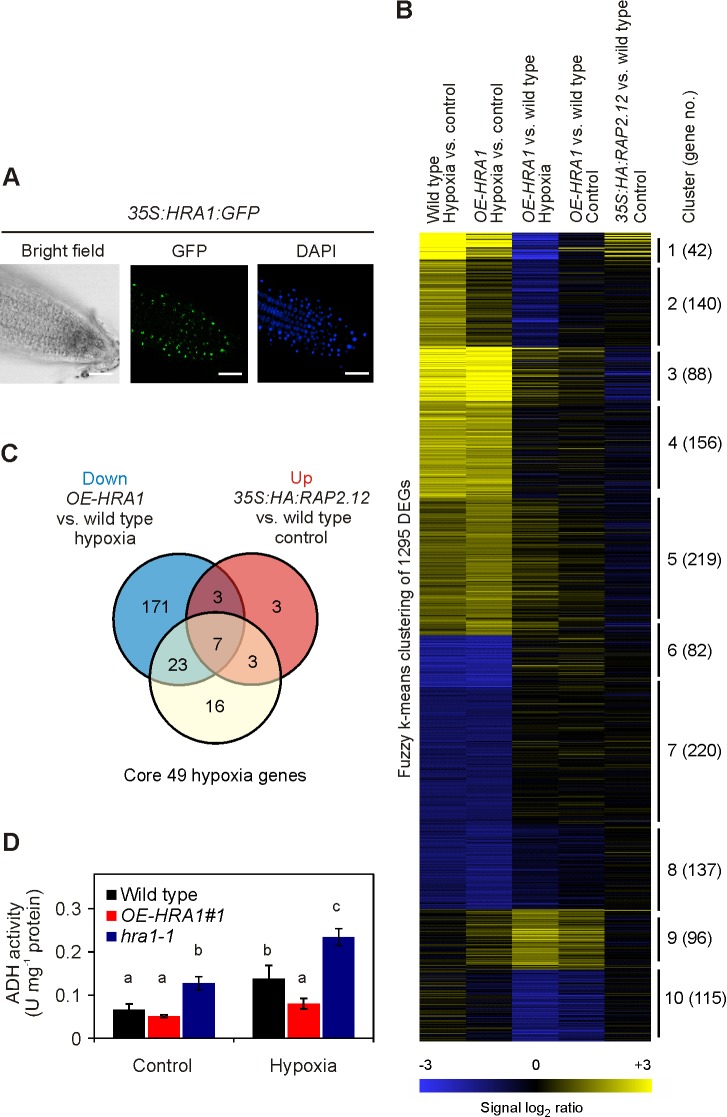
The nuclear factor HRA1 attenuates the expression of hypoxia-responsive genes.(A) Subcellular localization of the HRA1:GFP protein in root cells. Nuclei were visualized by DAPI staining. Scale bar, 30 µm. (B) Differential gene expression in OE-HRA1 and wild type seedlings under air or hypoxia (2 h), compared with 35S:HA:RAP2.12 transgenics. (C) Venn diagram describing the overlap between genes with opposing regulation by HRA1 or RAP2.12 and 49 genes induced across cell types by hypoxia in wild type seedlings [13]. (D) ADH enzyme activity is affected by altered levels of HRA1 in plants at the seedling stage (mean ± s.d., one-way ANOVA, p<0.05, n = 3). Hypoxia, 3 h.